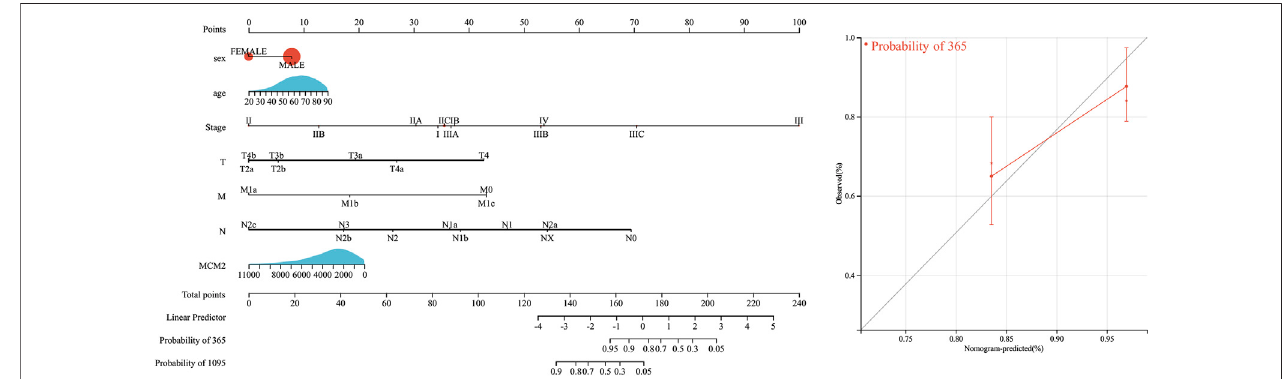
FIGURE 12 | Survival nomogram and calibration curves. Prediction of 1-year and/or 3-year OS in SKCM